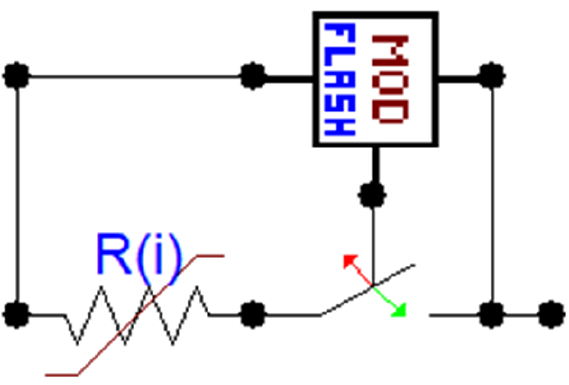
Figure 3. Composite surge arrester model.